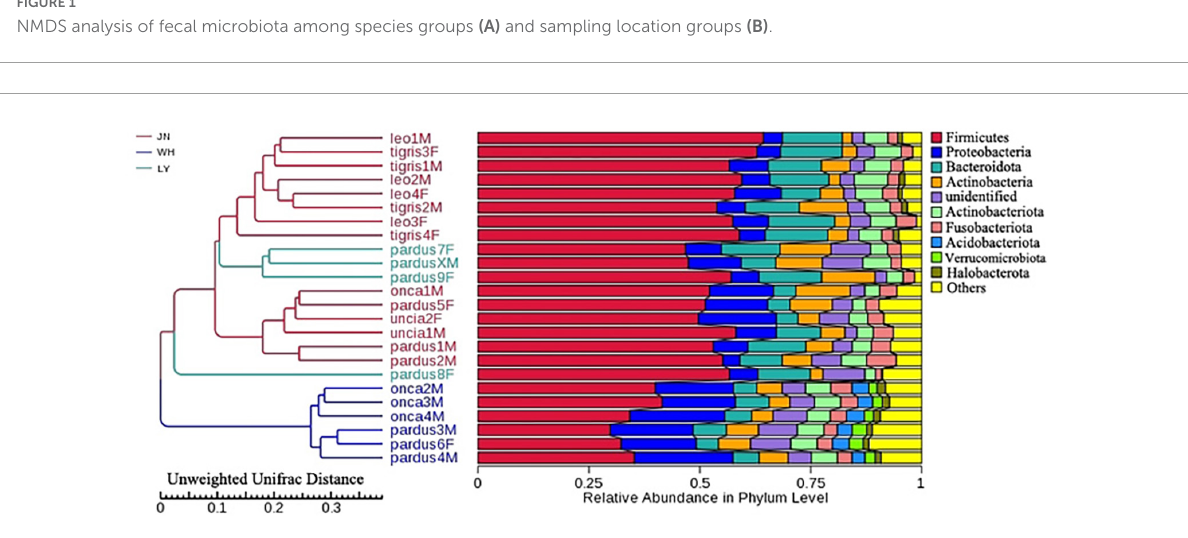
FIGURE2 The UPGMA clustering analysis of fecal microbiota based on unweighted UniFrac distance.